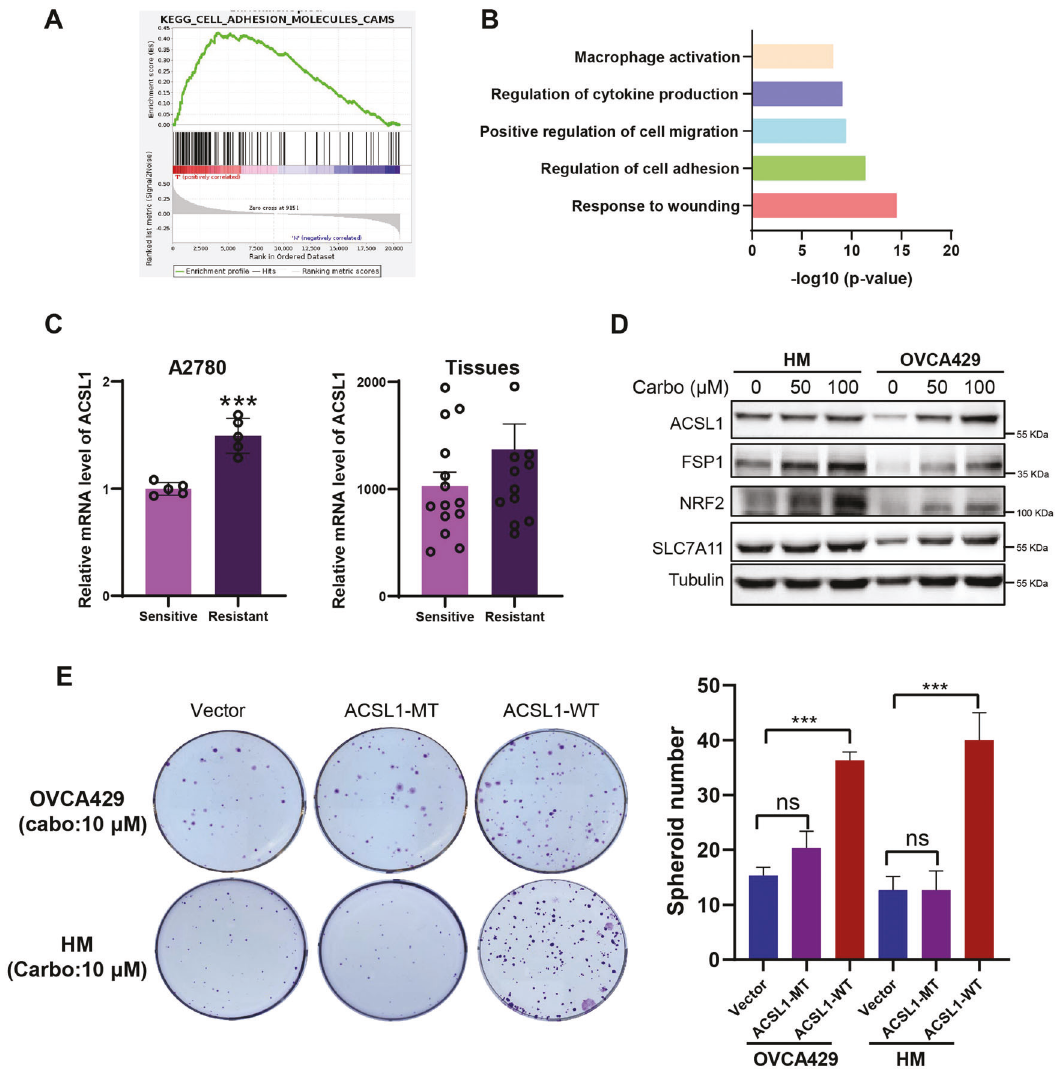
Fig. 5 ACSL1 participates in carboplatin therapy for ovarian cancer by regulating cell ferroptosis. A GSEA analysis of the activation and expression of gene pathways in cancer tissues from patients with high and low ACSL1 expression. B GO analysis suggests that genes co- expressed with ACSL1 are involved in biological processes such as cell migration, adhesion, and secretion of immune factors. C Expression of ACSL1 gene mRNA in carboplatin-sensitive and carboplatin-resistant cancer tissues (right) and in the A2780 cell line (left). D After carboplatin treatment of HM and OVCA429 cells, the expression of ACSL1 and ferroptosis hallmark proteins was detected. E The spheroid formation ability of OVCA429 and HM cell after expression ACSL1-WT or ACSL1-MT vectors and treatment with carboplatin. The live spheroids were reseeded into standard 6-well plates and allowed to grow for a period of 7 – 10 days. Subsequently, they were stained with crystal violet for further analysis. *** P < 0.001 indicates statistical signi fi